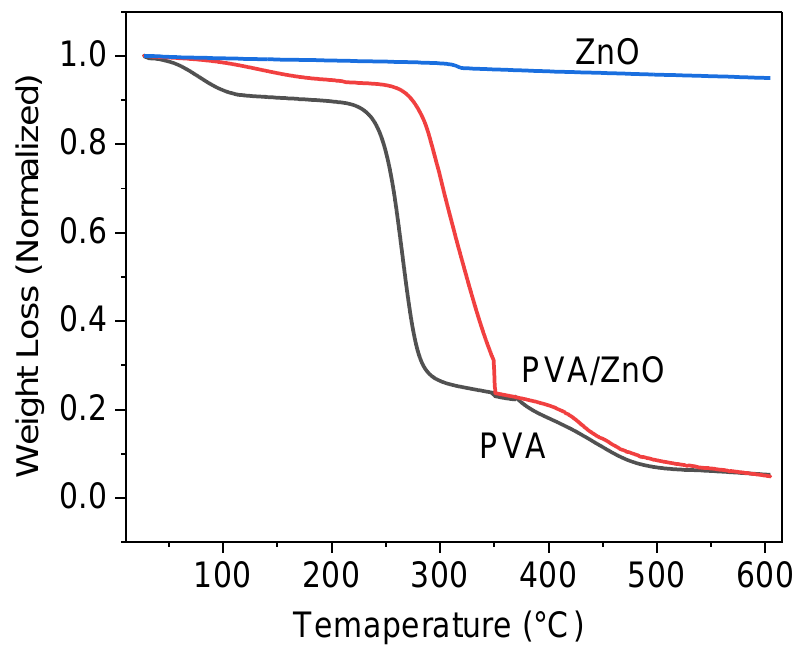
Figure 5. Thermogravimetric analysis (TGA) of nanorods of ZnO and prepared films, where the blue curve represents ZnO particles, the black curve represents pristine PVA films, and the red curve represents PVA/ZnO films.